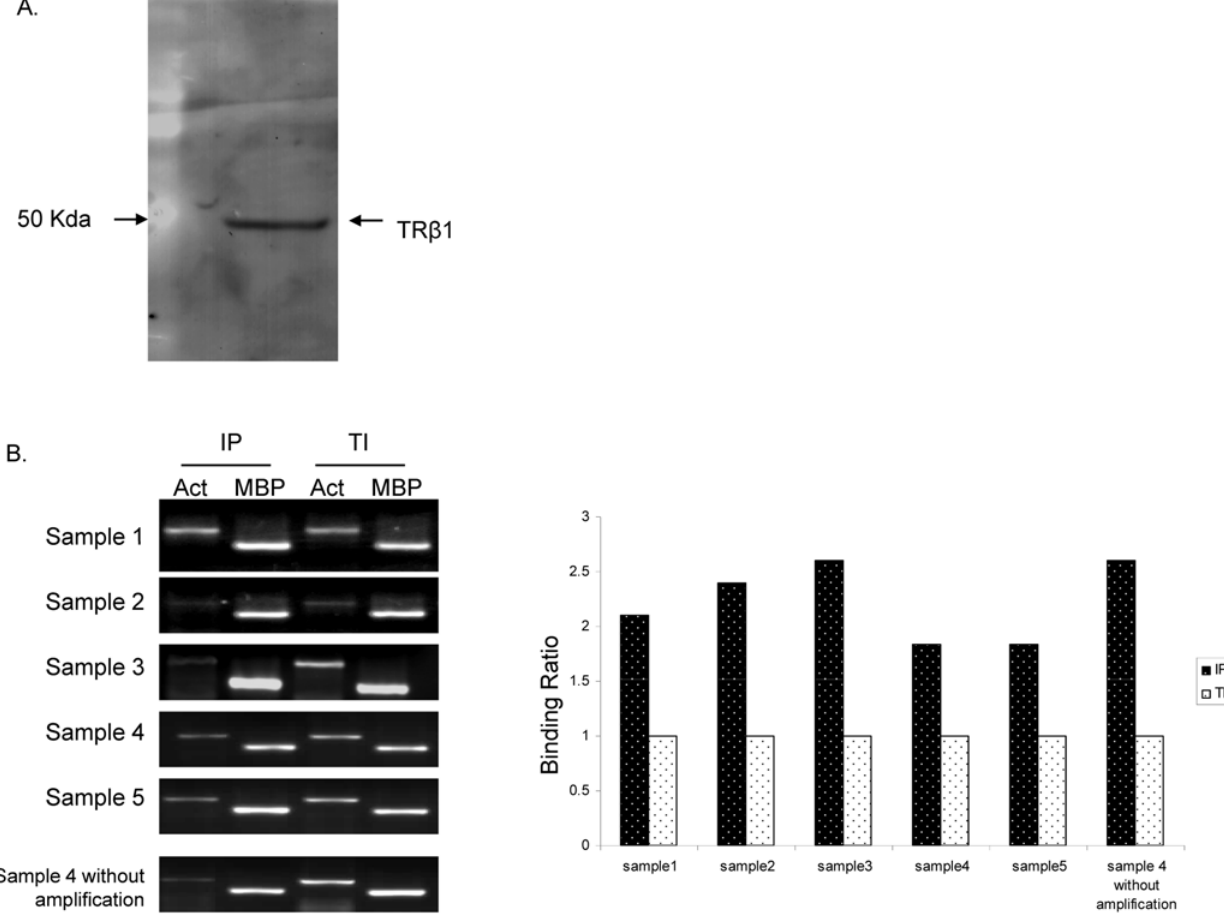
Figure 1. Assessing specificity of antibody and ChIP protocol. A. Characterization of TR b antibody with the GH3 cell line. A single 52 kDa band was detected with Western blot. B. Characterization of the enrichment of MBP-TRE in all cerebellum samples. Enrichment of fragments from the promoter region of b -actin and MBP was examined with PCR using IP and TI DNA amplified with WGA kit. One representative sample in the bottom shows the enrichment in non-amplified DNA. The right panel shows the enrichment ratio of MBP to b -actin calculated using quantified band intensities.